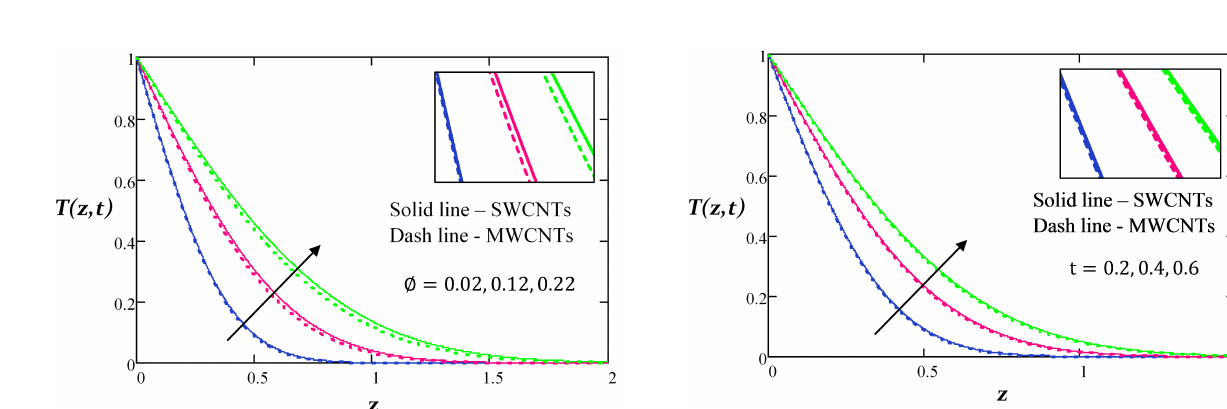
Fig. 2. f and g profiles under the impact of different φ values.